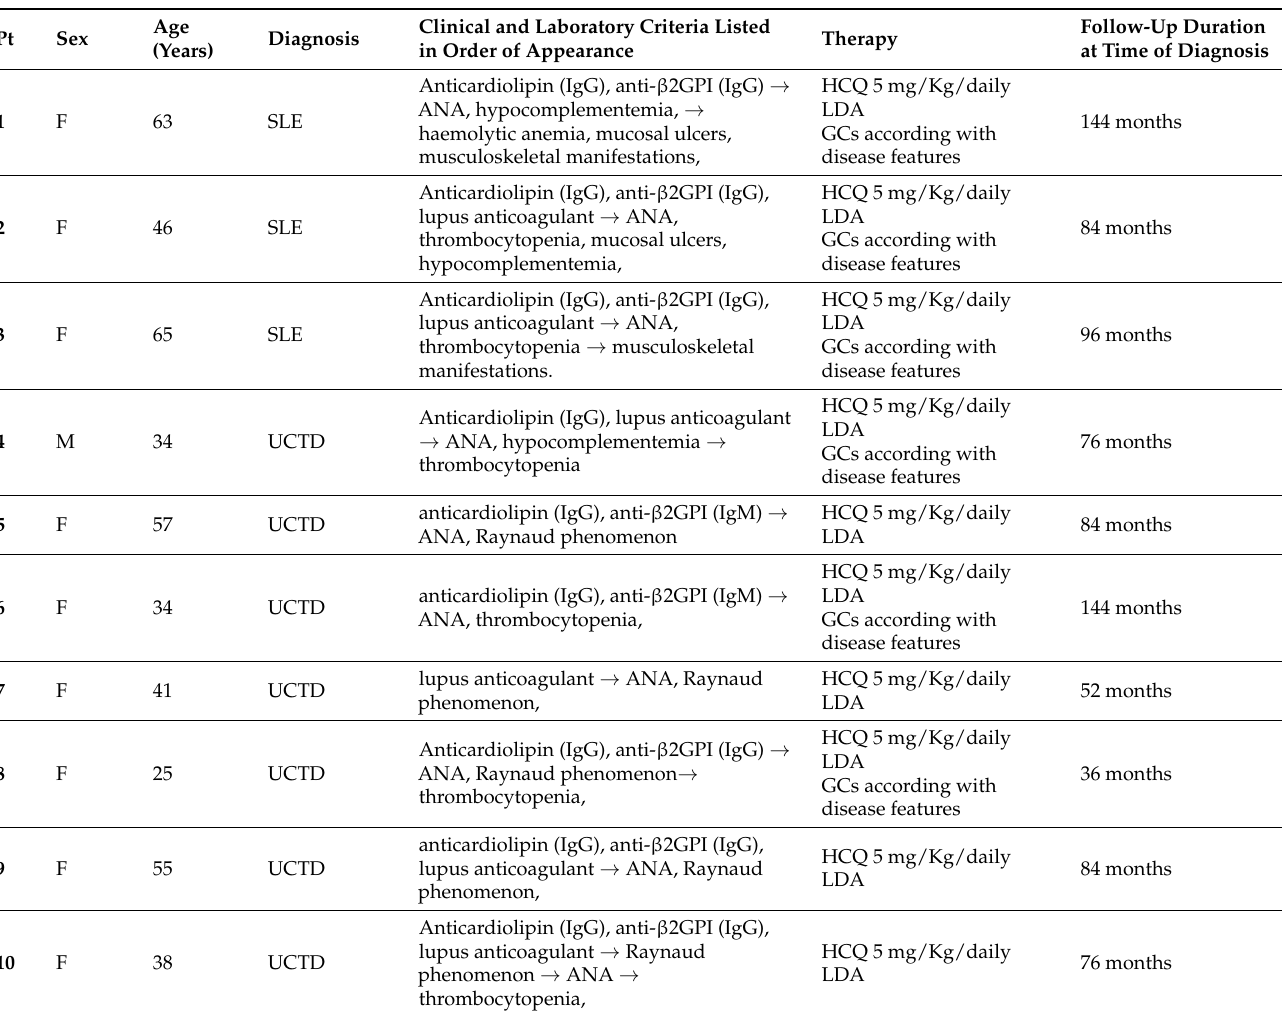
Table 2. Demographic, laboratory and clinical features of three patients reclassified as affected by SLE (2019 ACR/EULAR criteria) and seven as affected by